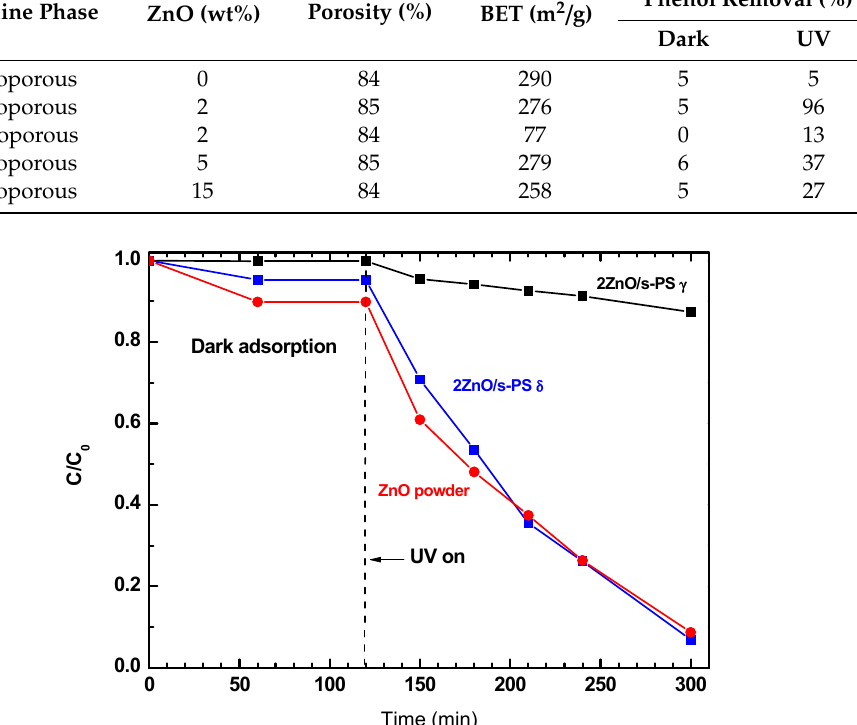
Figure 3. Phenol concentration in aqueous solutions treated with 2ZnO/s-PS δ and γ -form aerogels and ZnO powder. ZnO dosage = 0.08 g/L, phenol C 0 = 50 mg/L.